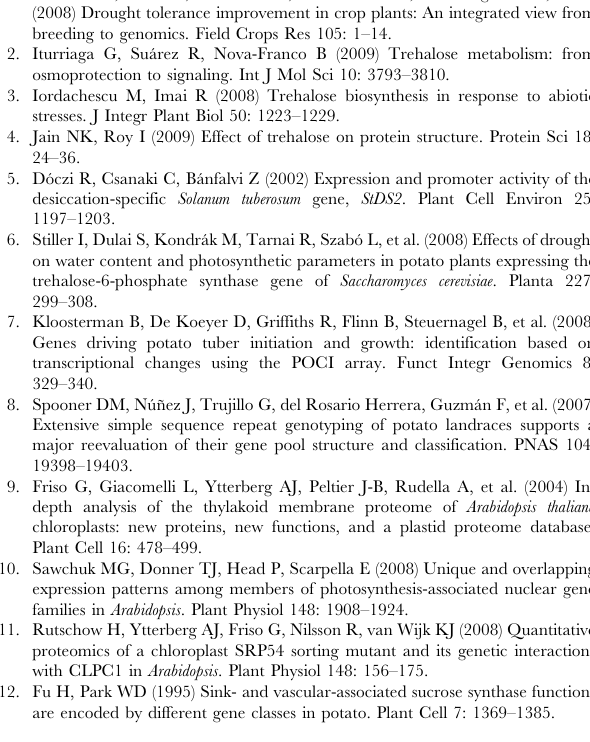
Table S1 List of differentially expressed genes not assigned to functional categories using MapMan software. Table S2 Functional annotation of differentially ex- pressed potato genes . Three approaches were used, functional grouping using MapMan software, BLAST searching of the S. phureja genome and searching the UniProt database for Solanaceae orthologs.